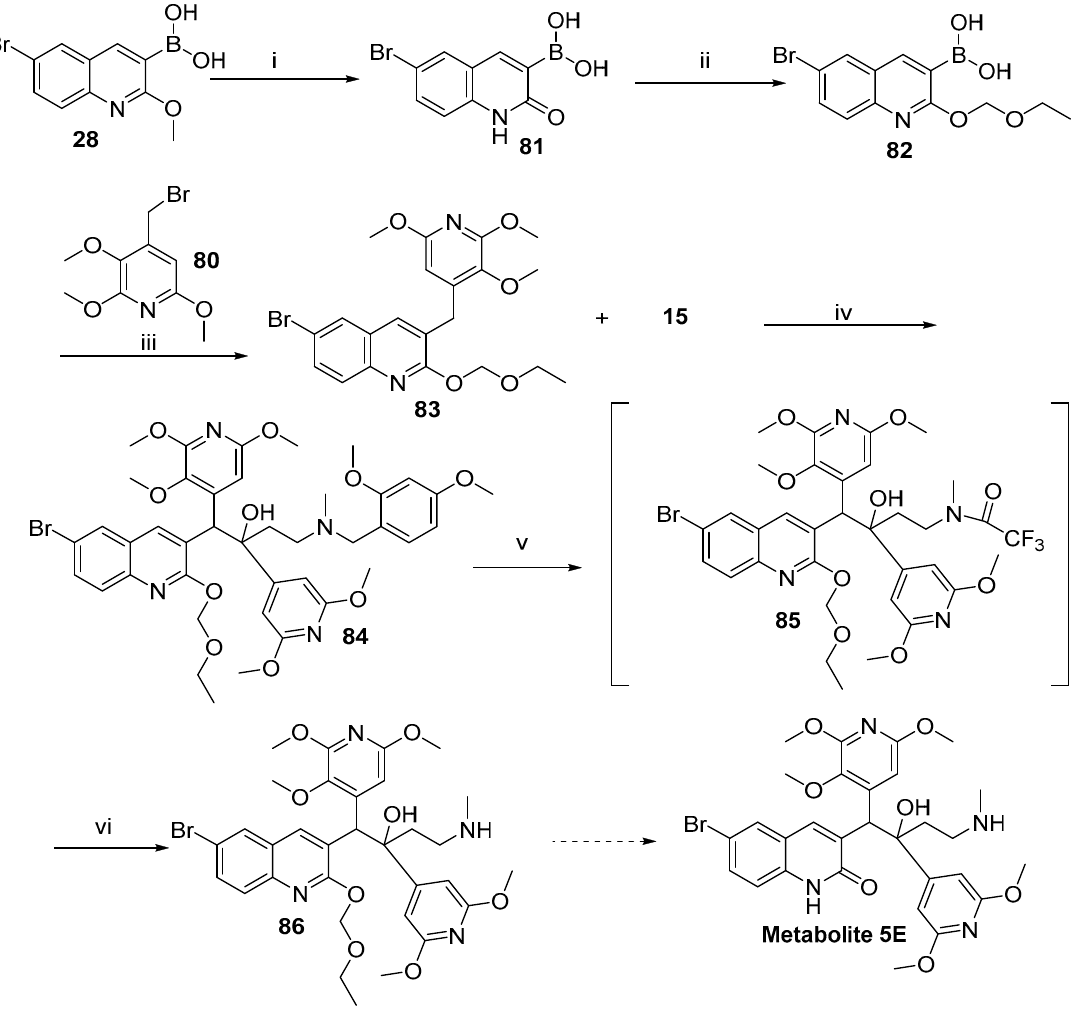
Scheme 21. Synthesis of key intermediates 83 and 86 . Reagents and conditions: (i) 1M BBr 3 in DCM, DMF, 24 h, 91%; (ii) DIPEA, chloromethyl ethyl ether, DMF, 66 h, 69%; (iii) Cs 2 CO 3 , Pd(PPh 3 ) 4 , PhMe / DMF, 50 ◦ C (sealed tube), 2.5 h, 71%; (iv) LDA, THF, − 75 ◦ C, 1.5 h then 15 , − 75 ◦ C, 5 h,